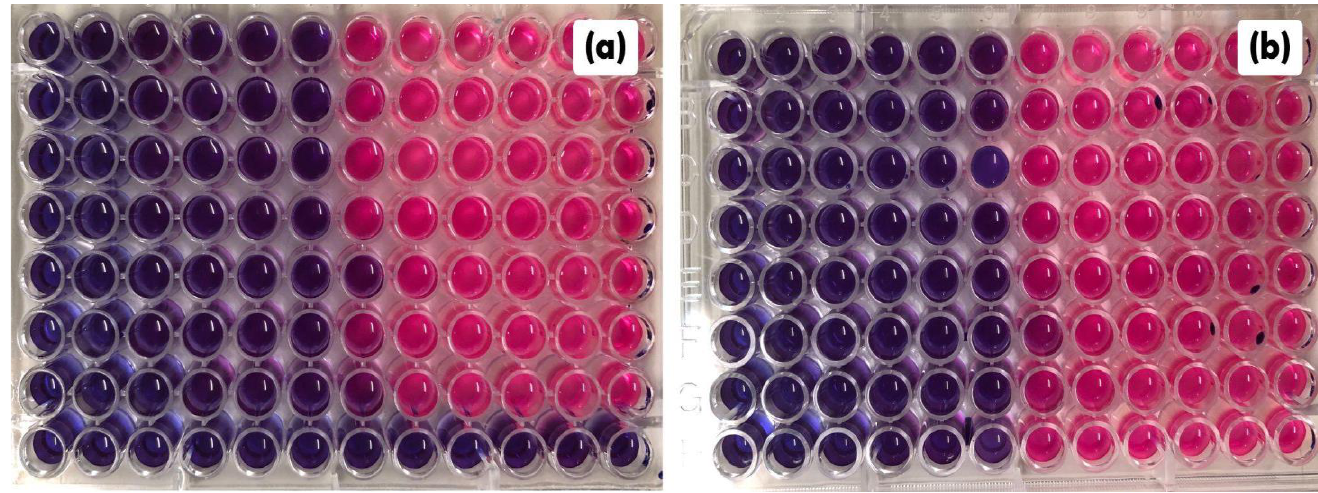
Figure 4. Checkerboard assay between C. conduplicatus essential oil with oxacillin ( a ) and C. conduplicatus essential oil with ampicillin ( b ) against the MRSA strain. The blue colour indicates the activity of the combined concentration. Table 4. Combination testing of C. conduplicatus essential oil with antimicrobials agents against MSSA and MRSA strains.